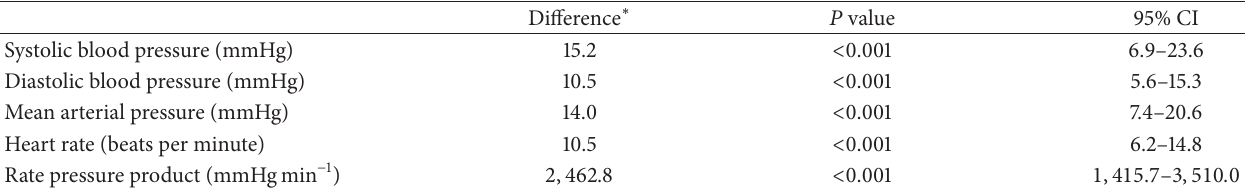
Table 2: The multivariate mean difference of systolic blood pressure, diastolic blood pressure, mean arterial pressure, and heart rate by treatment group adjusted for multiple variables † .